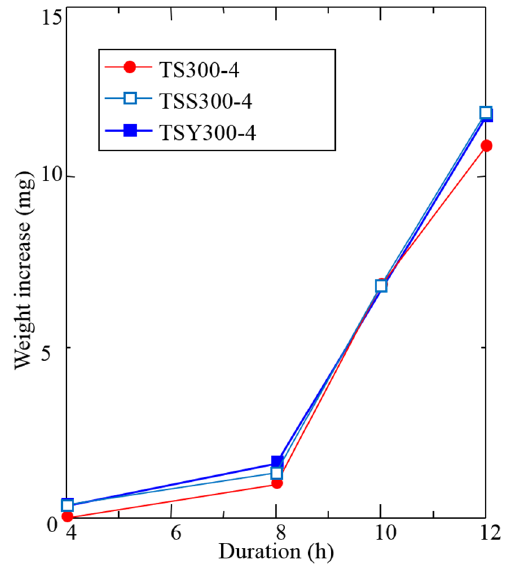
Figure 8. Weight increase of 50 steel balls during mechanical coating versus duration.